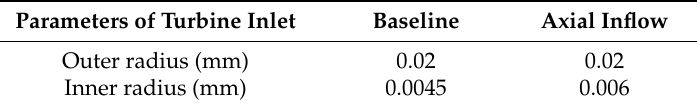
Table 4. Turbine